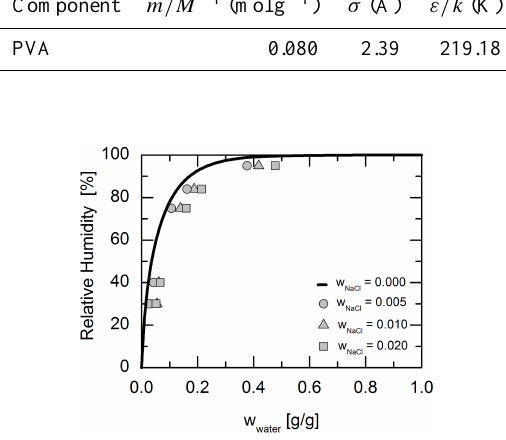
Figure A1. Water mass fraction in PVA/NaCl films as a function of the RH of the surrounding atmosphere and of NaCl content in the films at 298.15K. Symbols are experimental data at various NaCl mass fractions w NaCl of 0.005, 0.010, and 0.020; the line indicates the Flory–Huggins correlation in the absence of NaCl obtained from Jack et al.